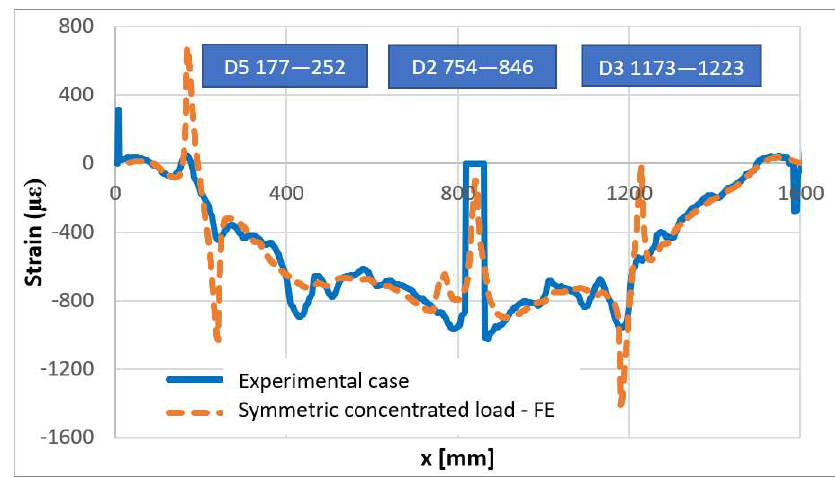
Figure 37. Numerical–experimental correlation—symmetric load.